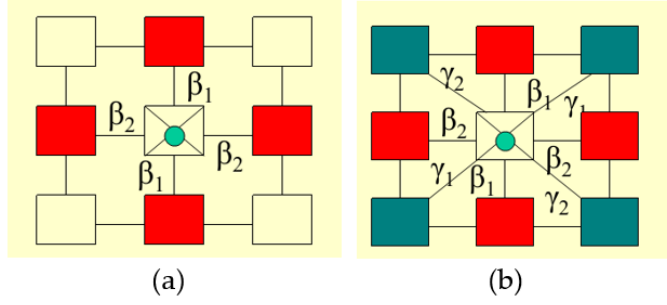
Figure 6. ( a ) First-order models and ( b ) second-order